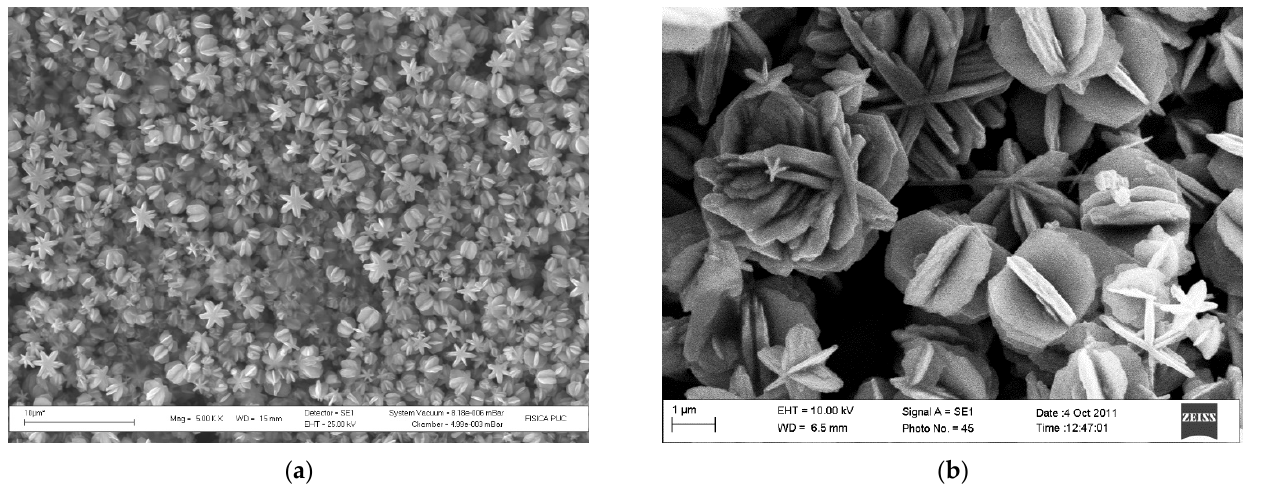
Figure 4. SEM Micrographs of Vanadium oxides: ( a ) High yield synthesis of vanadium oxides nanocogs. ( b ) V 6 O 11 architecture rotationally six folds layered material.